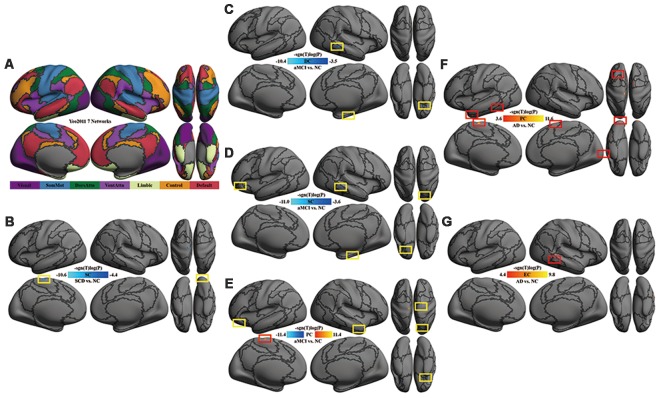
Multi-scale network centrality changes in AD progression. (A) The seven networks map in Yeo et al. (2011). (B) SC in SCD vs. NC. The reduced SC in SCD was located in the left somatomotor network (left paracentral cortex) and the right visual network (right occipital cortex). (C) DC in aMCI vs. NC. The reduced DC in aMCI were located in the right default network (orbital gyri), the right limbic network (parahippocampal areas) and the right frontoparietal control network (middle temporal area). (D) SC in aMCI vs. NC. Except for the default, limbic and frontoparietal control network, the reduced SC in aMCI extended to the left default network (orbital cortex) and the right dorsal attention network (superior parietal areas). (E) PC in aMCI vs. NC. Significant decreases of PC in aMCI were observed within the default network (right middle temporal and bilateral orbital gyrus), the right somatomotor network (precentral area), the right dorsal attention network (superior parietal area) and the left limbic network (orbital areas), whereas significant increases of PC in aMCI were detectable within the left somatomotor network (paracentral area). (F) PC in AD vs. NC. The increased PC in AD were located in the visual network (occipital areas), the left somatomotor network (paracentral area), the left limbic network (temporal pole), the left dorsal attention network (inferior temporal area), the left default network (superior frontal gyrus) and the right ventral attention network (superior frontal area). (G) EC in AD vs. NC. A significant increase of EC was found in the right frontoparietal control network (inferior temporal sulcus). All the above tests were thresholded at an false discovery rate (FDR) corrected significance level of p < 0.05. Gray curves indicate the boundaries according to the seven networks map in Yeo et al. (2011). Abbreviations: NC = normal control; SCD = subjective cognitive decline; aMCI = amnestic mild cognitive impairment; AD = Alzheimer’s disease; DC = degree centrality; SC = subgraph centrality; PC = page-rank centrality; EC = eigenvector centrality.